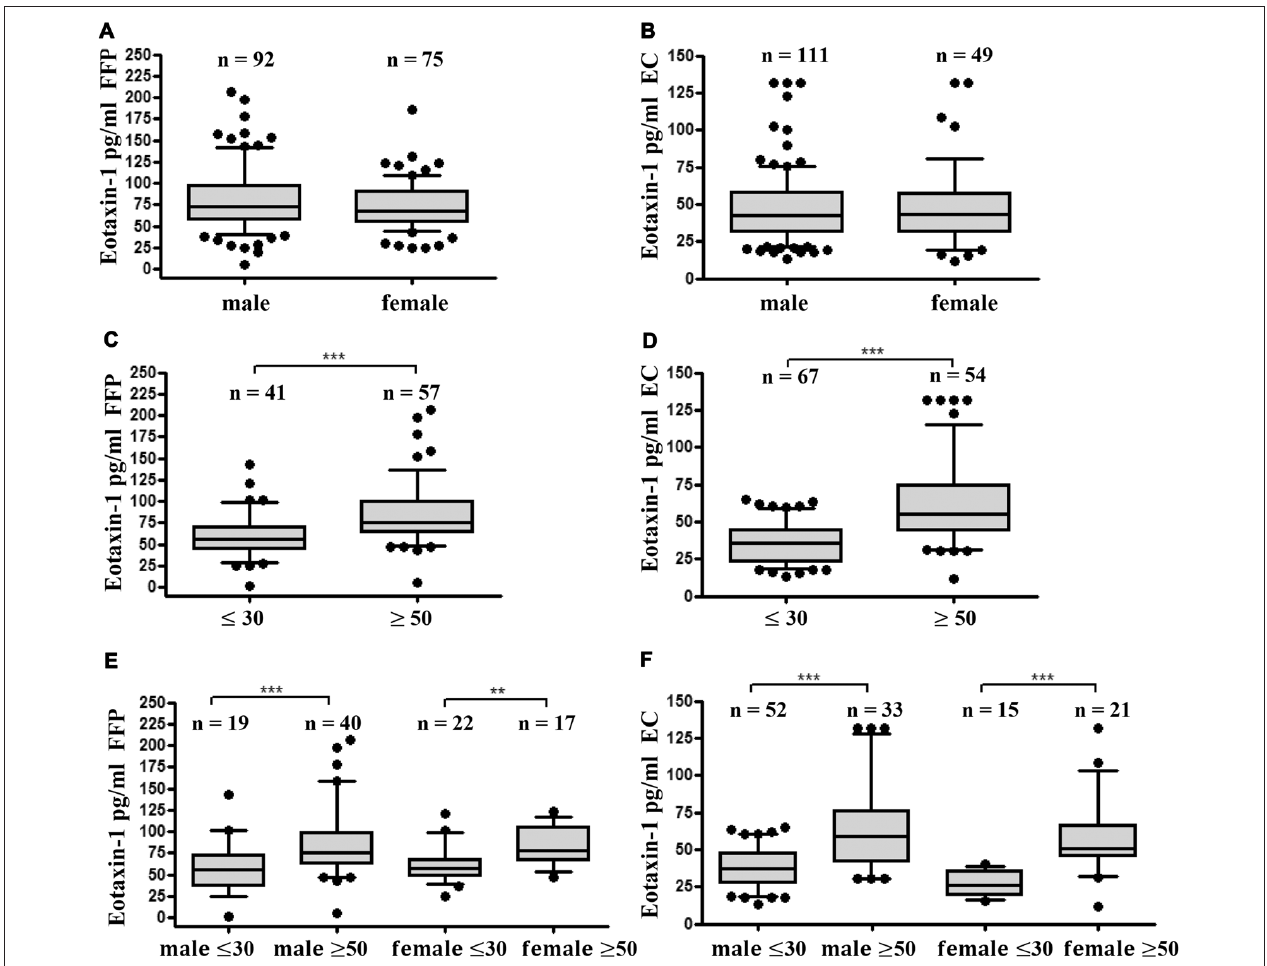
FIGURE 2 | Eotaxin-1 is comparable in male and female donors but is increased in older donors. (A,B) Eotaxin-1 was measured in (A) FFP and (B) EC and analyzed in dependence of gender. Data are presented as Box-Whiskers Plot, showing median and 10–90 percentiles. (C,D) Eotaxin-1 was measured in (C) FFP and (D) EC and analyzed in dependence of age. Data are presented as Box-Whiskers Plot, showing median and 10–90 percentiles. Statistical analysis was performed using Mann-Whitney U test ( ∗∗∗ p < 0.001). (E,F) Eotaxin-1 was measured in (E) FFP and (F) EC and analyzed in dependence of age and gender. Data are presented as Box-Whiskers Plot, showing median and 10–90 percentiles. Statistical analysis was performed using Kruskal-Wallis one way ANOVA test including Dunn’s post hoc analysis ( ∗∗ p < 0.01; ∗∗∗ p <